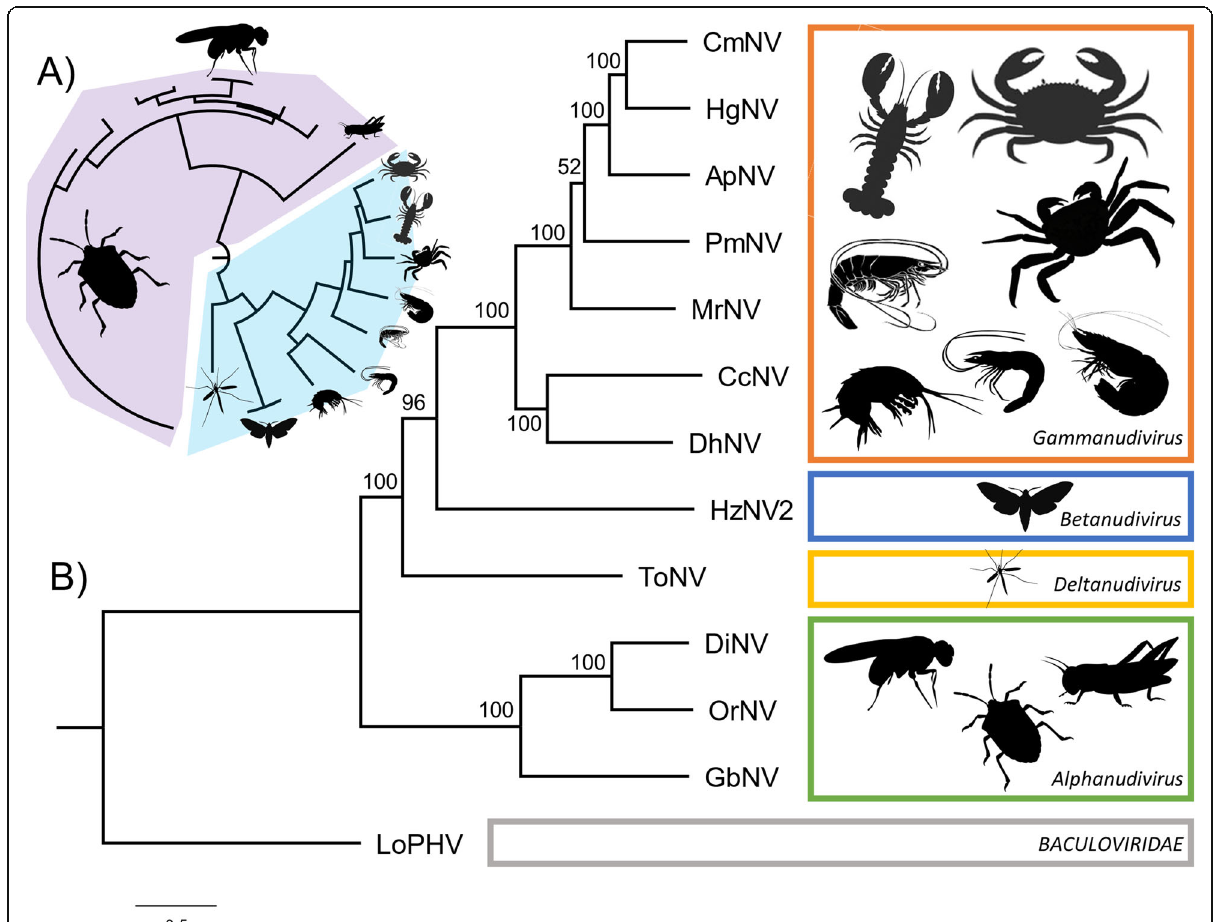
Fig. 4 Maximum-likelihood phylogenetic trees of the Nudiviridae , including Aratus pisonii nudivirus (ApNV). The radial plot ( A ) represents all available Nudiviridae DNA polymerase protein sequences and highlights the potential for two sub-families suggested in recent literature. B ApNV groups in the Gammanudivirus most closely with Homarus gammarus nudivirus (United Kingdom) and Carcinus maenas nudivirus (invasive host, Canada). Lonomia obliqua nucleopolyhedrovirus ( Baculoviridae ) is used as an outgroup to root the concatenated protein tree, which was developed from the following